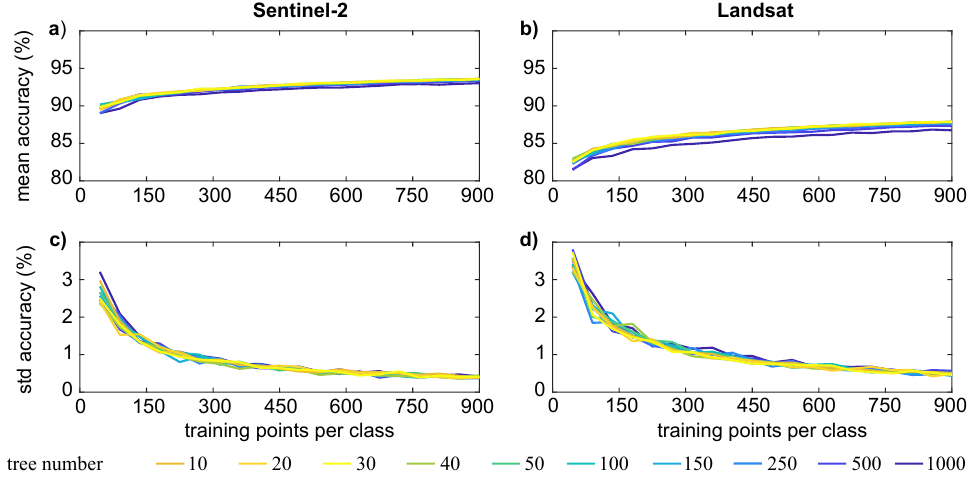
Figure 4. Mean and standard deviation (std) of the accuracy for increasing number of training points when the classification relies on Sentinel-2 ( a , c ) or Landsat ( b , d )